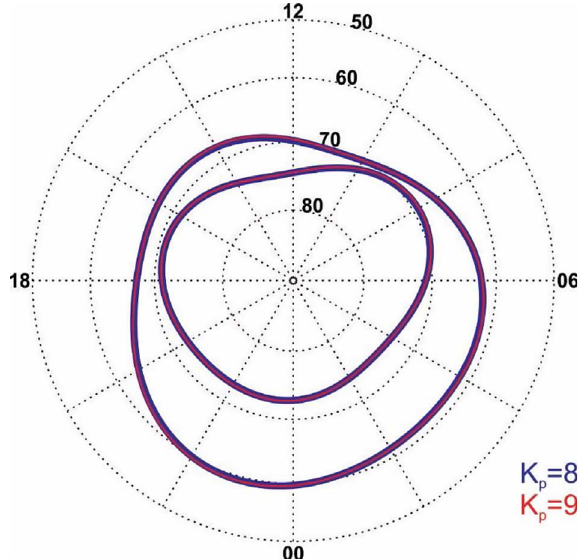
Fig. 1. Poleward and equatorward edge of the auroral oval modeled using the Starkov (1994) auroral boundary model as summarized in Sigernes et al. (2011). Boundaries are plotted for Kp = 8 (blue) and Kp = 9 (red) in magnetic latitude/magnetic local time coordinates. Because of the almost perfect overlap of the contours, the Kp = 8 boundary is plotted with a thicker line. Dashed lines indicate a magnetic latitude in 10 (cid:3) increments and magnetic local time in 2-h increments. Kp = 8 and Kp = 9 were chosen to represent moderate and severe activity, as described by the ICAO thresholds for auroral absorption, see Section